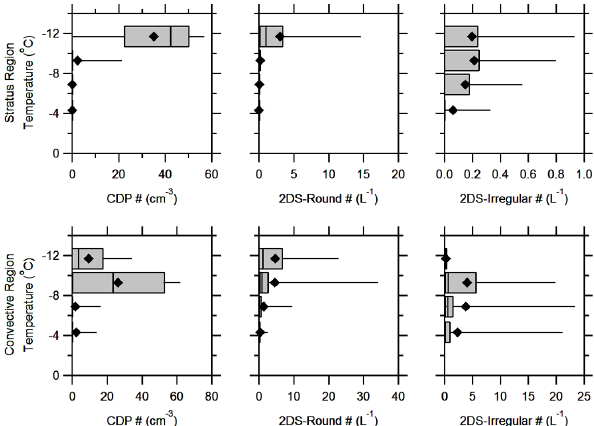
Fig. 10. Number concentration of round particles recorded by the 2DS probe from runs R2-R5. Whiskers extend to 5th and 95th per- centiles, boxes encompass 25th to 75th percentiles and 50th per- centiles are vertical lines. Mean values are represented by black markers. The convective region is defined as being 15–25km dis- tance from CFARR, whereas the stratus region is defined as being 25–100km from